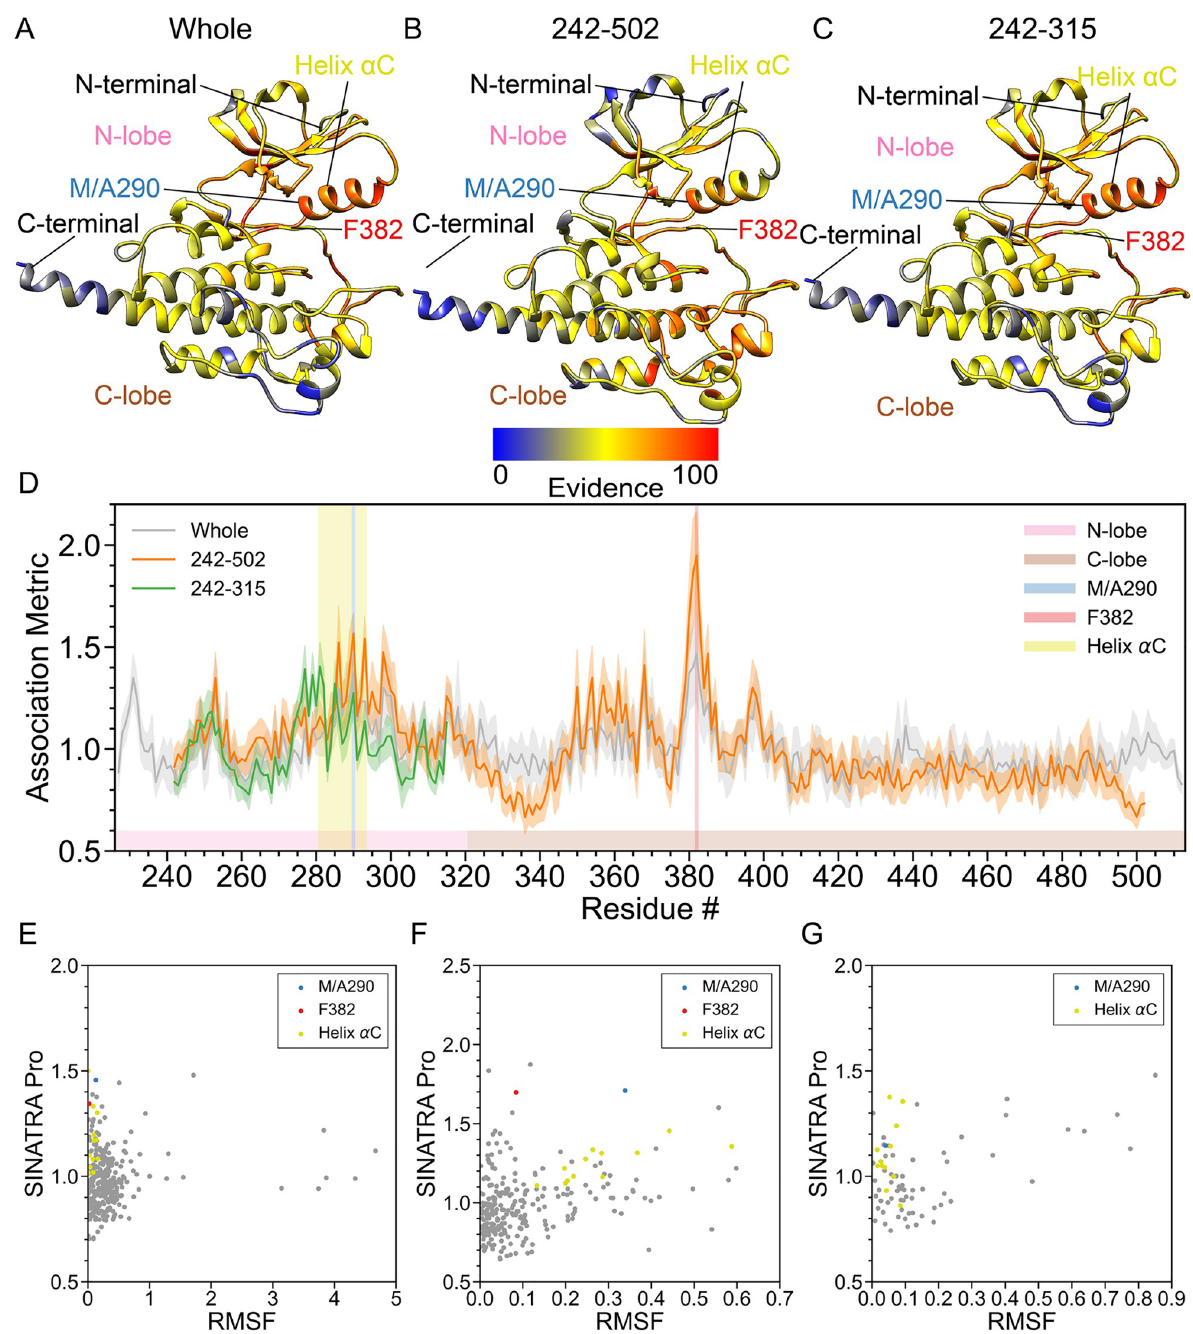
Fig 5. Real data analyses identify enrichment in the N-terminal pocket of the Abl1 Tyrosine protein kinase due to a M290A mutation in the α C helix. In this analysis, we compare the molecular dynamic (MD) trajectories of wild-type Abl1 versus M290A mutants [2, 43, 89–91]. For both phenotypic classes, structural data are drawn from equally spaced intervals over a 150 ns MD trajectory (e.g., t MD = [0, 1, 2, 3, ... , 99] × 1.5 ns + δ , where δ is a time offset parameter). Altogether, we have a final dataset of N = 3000 proteins in the study: 150 ns long interval × 15 different choices δ = {0.0, 0.1, 0.2, ... , 1.4} ns × 2 phenotypic classes (wild-type versus mutant). This figure depicts results after applying SINATRA Pro using parameters { r = 6.0 Å , c = 20, d = 8, θ = 0.80, l = 120} chosen via a grid search. The heatmaps in panels (A) - (C) highlight residue evidence potential on a scale from [0–100]. A maximum of 100 represents the threshold at which the first residue of the protein is reconstructed, while 0 denotes the threshold when the last residue is reconstructed. Panel (A) shows residue-level evidence potential when applying SINATRA Pro to the whole protein, while panels (B) and (C) illustrate results when strictly applying the SINATRA Pro pipeline to atoms in residues 242–502 and 242–315, respectively. Annotated regions of interest are color coded and correspond to the shaded residue windows in panel (D) . Panel (D) shows the association metrics